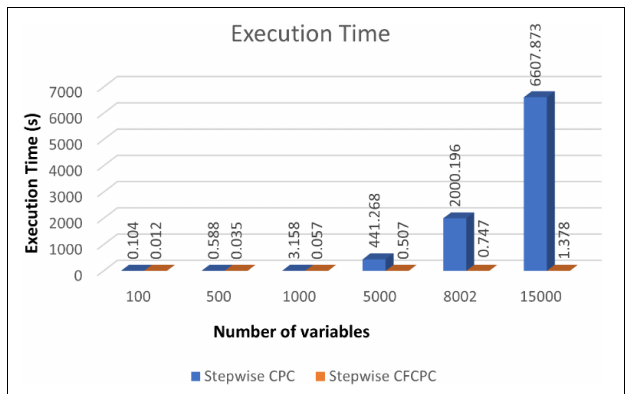
FIGURE 2 | Execution time comparison between stepwise CPC and stepwise CFCPC. Blue bars represent stepwise CPC, and orange representing stepwise CFCPC. Execution time is shown on the y-axis and x-axis, representing the number of variables.